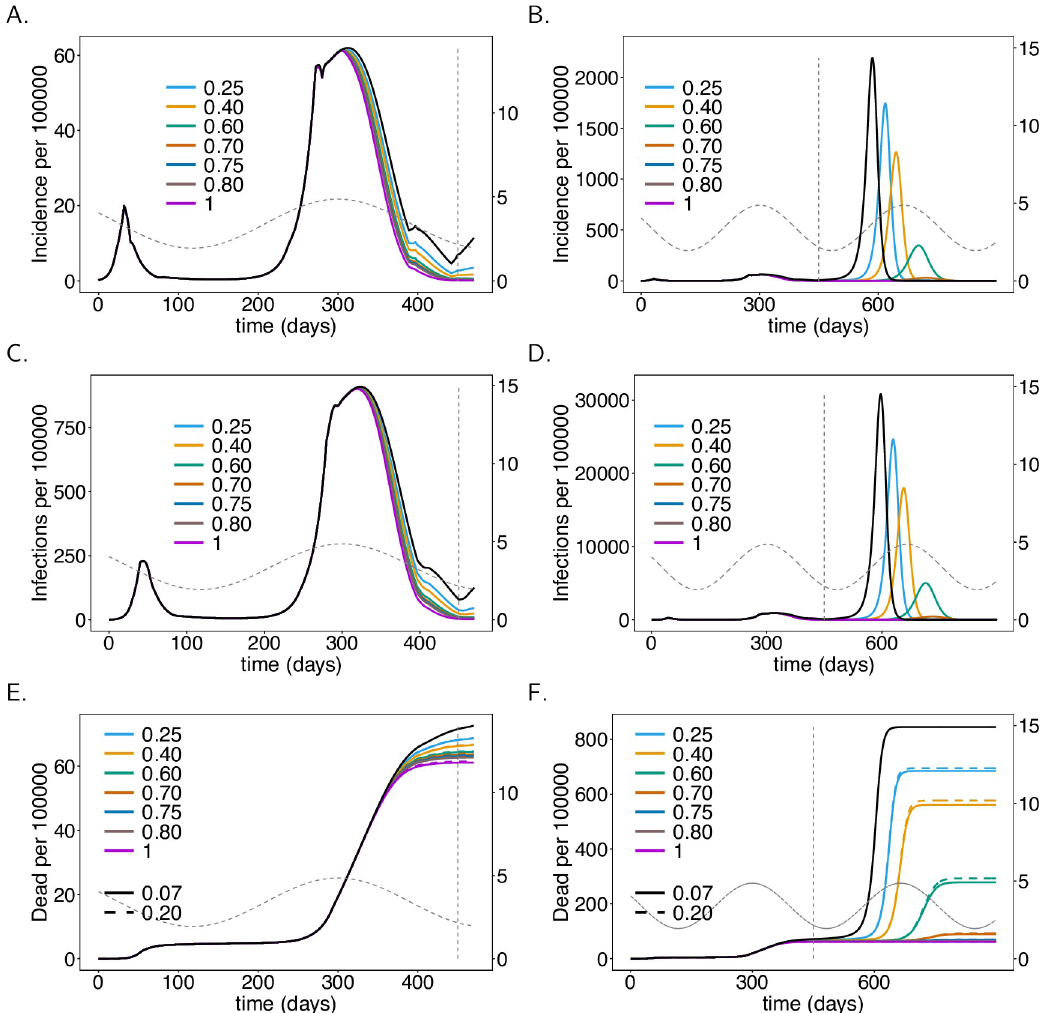
Fig 5. Vaccination coverage. As Fig 4, but for different vaccination coverage